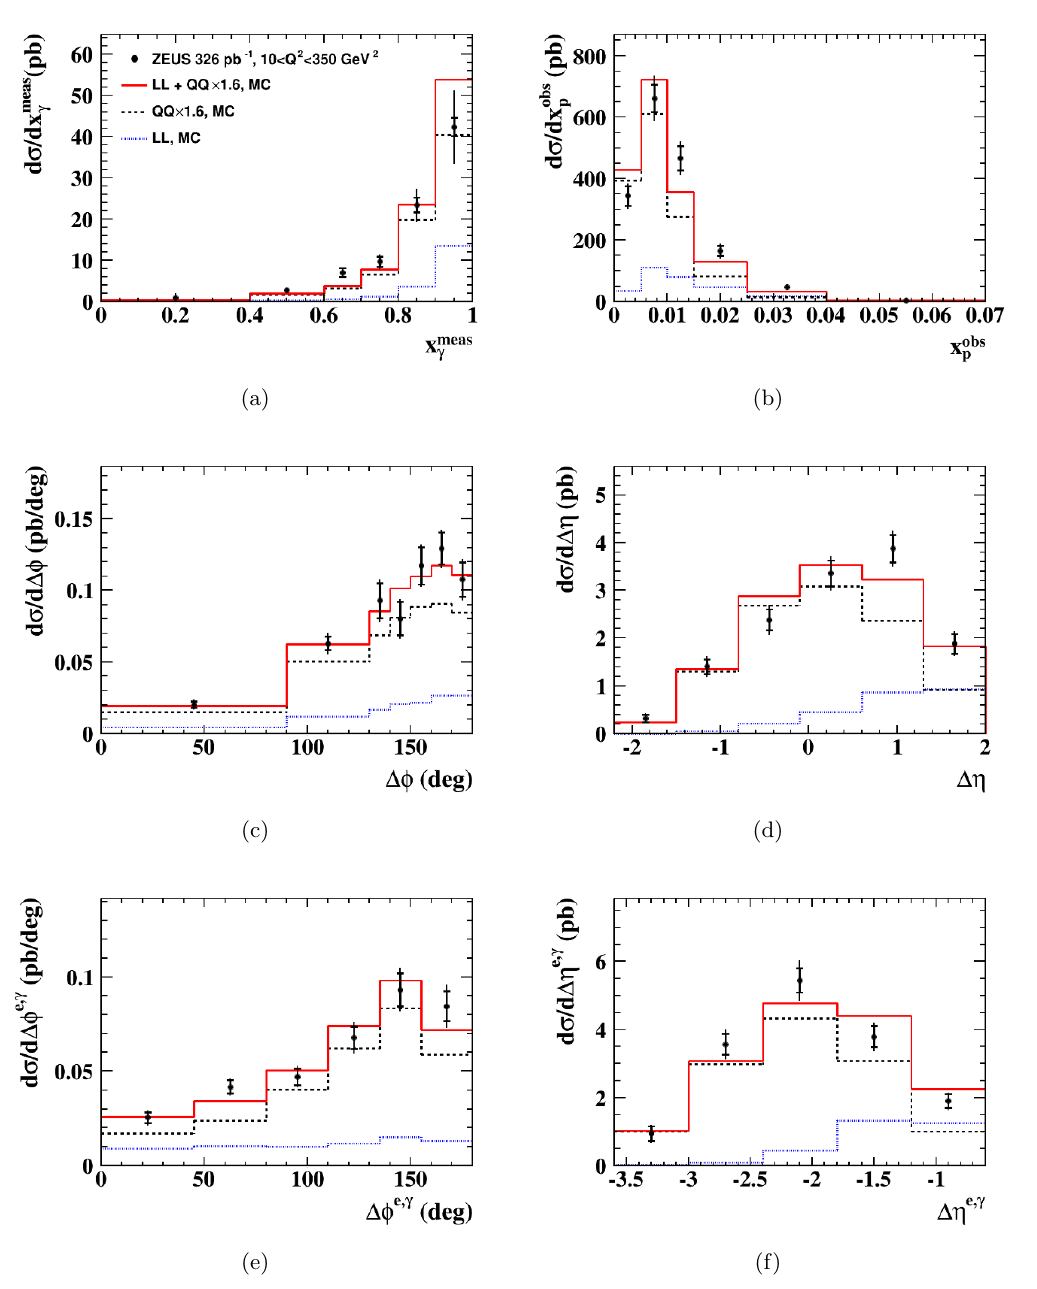
Figure 3 . Di(cid:11)erential cross sections in (a) x meas , (b) x obs , (c) (cid:1) (cid:30) , (d) (cid:1) (cid:17) , (e) (cid:1) (cid:30) e;(cid:13) , and (f) (cid:13) p (cid:1) (cid:17) e;(cid:13) , for the full range 10 < Q 2 < 350 GeV 2 . The inner and outer error bars show, respectively, the statistical uncertainty and the statistical and systematic uncertainties added in quadrature. The solid histograms are the Monte Carlo predictions from the sum of QQ photons from Pythia normalised by a factor 1.6 plus Djangoh-Heracles LL photons. The dashed (dotted) lines show the QQ (LL) contributions.